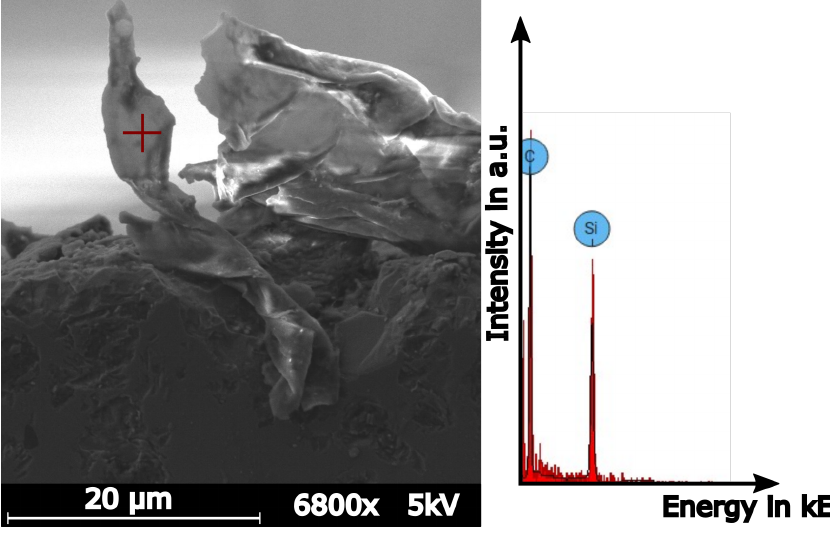
Figure 10. A recovered ductile chip. EDS analysis shows a composition of silicon and